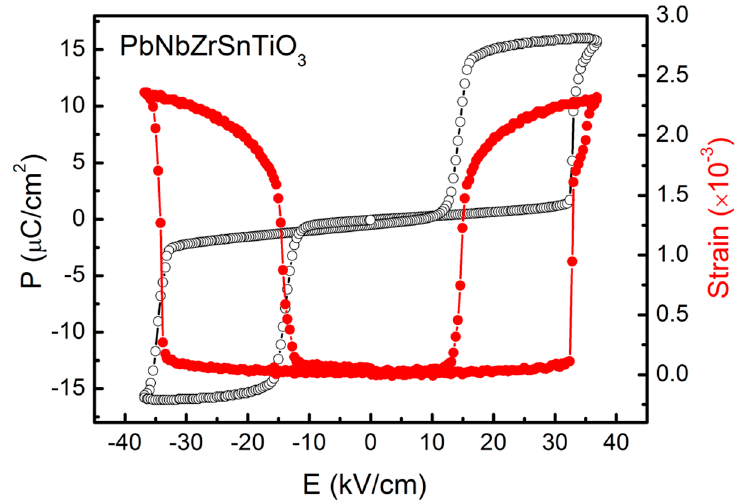
Figure 2. Antiferroelectric materialcharacterization. Polarisation (open discs) and out-of-plane strain (closed discs) loops as a function of applied electric field are shown for an antiferroelectric PbNbZrSnTiO 3 material of 500 μ m thickness. Antiferroelectric to ferroelectric phase transition occurs above 30 kV/cm.